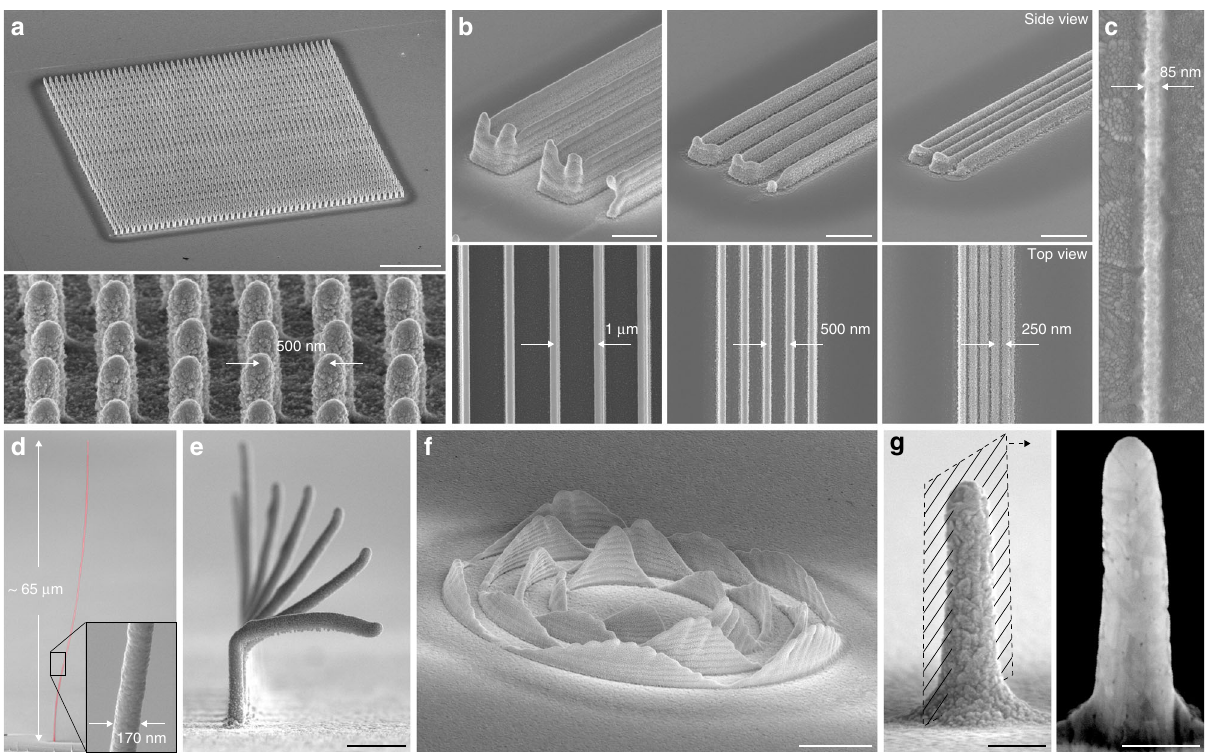
Fig. 3 Geometrical performance and as-printed microstructure. a Array of 50 × 50 Cu pillars printed with a point-to-point spacing of 500 nm. Scale bar: 5 μ m. b Walls printed at decreasing wall-to-wall spacing, with a minimum spacing of 250 nm. Height: ten layers for the leftmost image, three layers for the others. Scale bars: 1 μ m. c Printed Cu line less than 100 nm in width. d Cu wire with an aspect ratio of approximately 400. e Overhangs formed by a